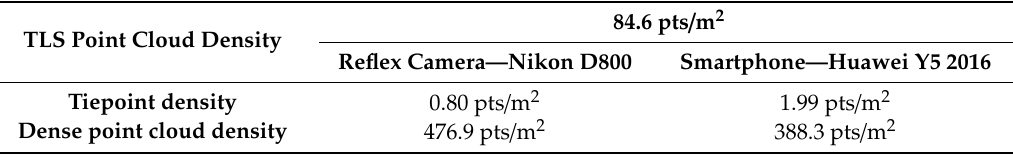
Table 3. Comparison of point density for TLS and SfM reconstructions.